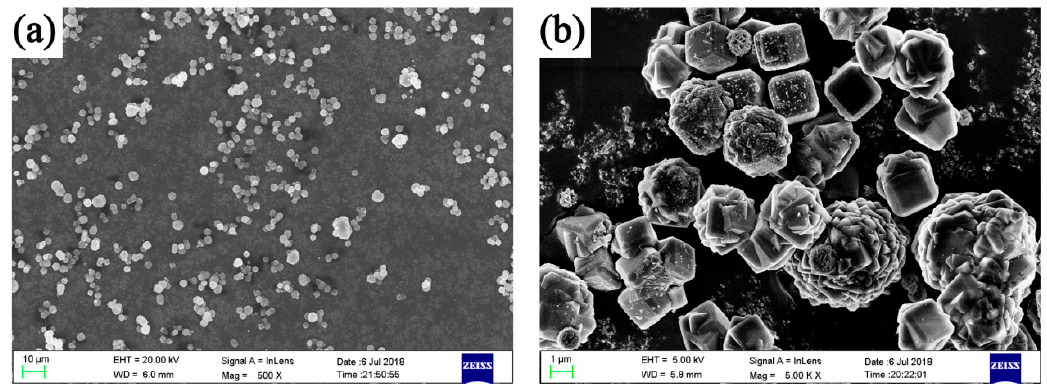
Figure 2. SEM images of the far-infrared radiation (FIR) ceramic powders at different magnifications.